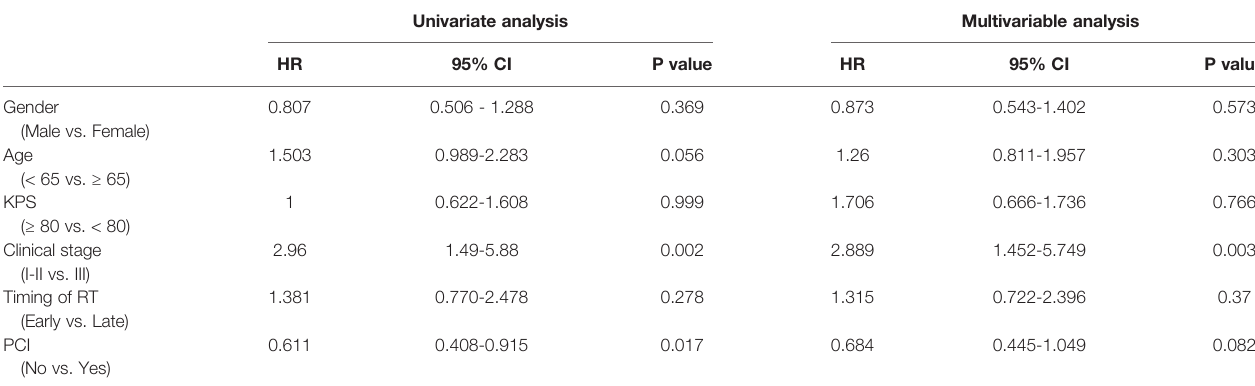
TABLE 2 | Result of univariate analysis and multivariable analysis.